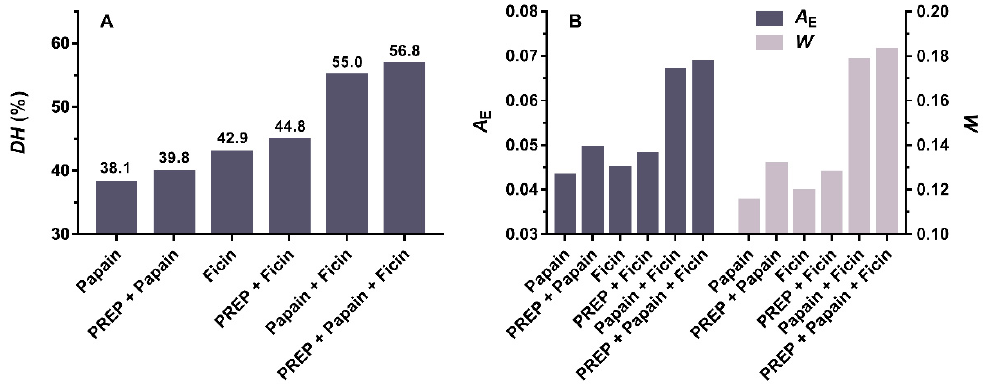
Figure 1. Degrees of hydrolysis ( DH ), release frequency ( A E ), and relative frequency ( W ) of the myosin heavy chain of Todarodes pacificus digested by different enzymes. PREP represented prolyl endopeptidase.